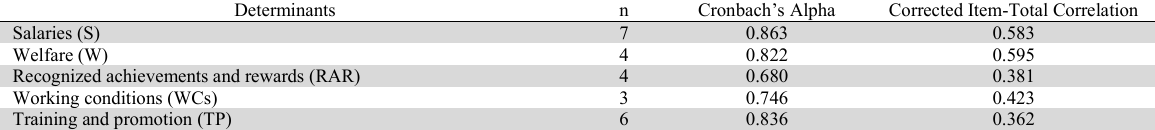
Results of analysis of Determinants Confidence of Scales in the Model